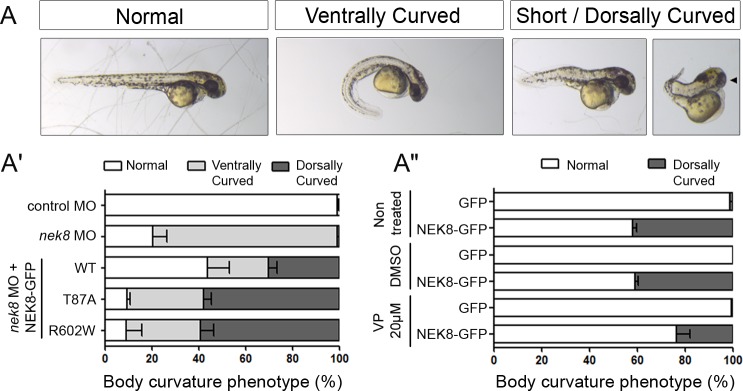
NEK8 overexpression in zebrafish induces Hippo pathway deregulation.(A) Representative pictures of the different classes of body phenotype observed upon nek8 morpholino (MO) or human NEK8-GFP RNA injections in zebrafish embryos. Arrowhead points out cyclopia observed in a subset of short embryos. (A’) Graph showing the distribution of the three classes of body axis curvature observed in rescue experiments with WT or mutated (T87A, R602W) NEK8-GFP RNA forms. 30% of embryos co-injected with nek8 MO and WT NEK8-GFP RNA exhibited a stunted dorsally curved body axis similar to embryos injected with human YAP RNA. Data are from three independent experiments (n = 90 to 180 embryos). (A”) Graph showing the distribution of normal and stunted dorsally curved animals among GFP or WT NEK8-GFP RNA injected embryos upon Verteporfin (VP) treatment. A partial rescue of the phenotype can be observed in the presence of 20 μM Verteporfin. Data are from four independent experiments (n = 120 to 240 embryos).